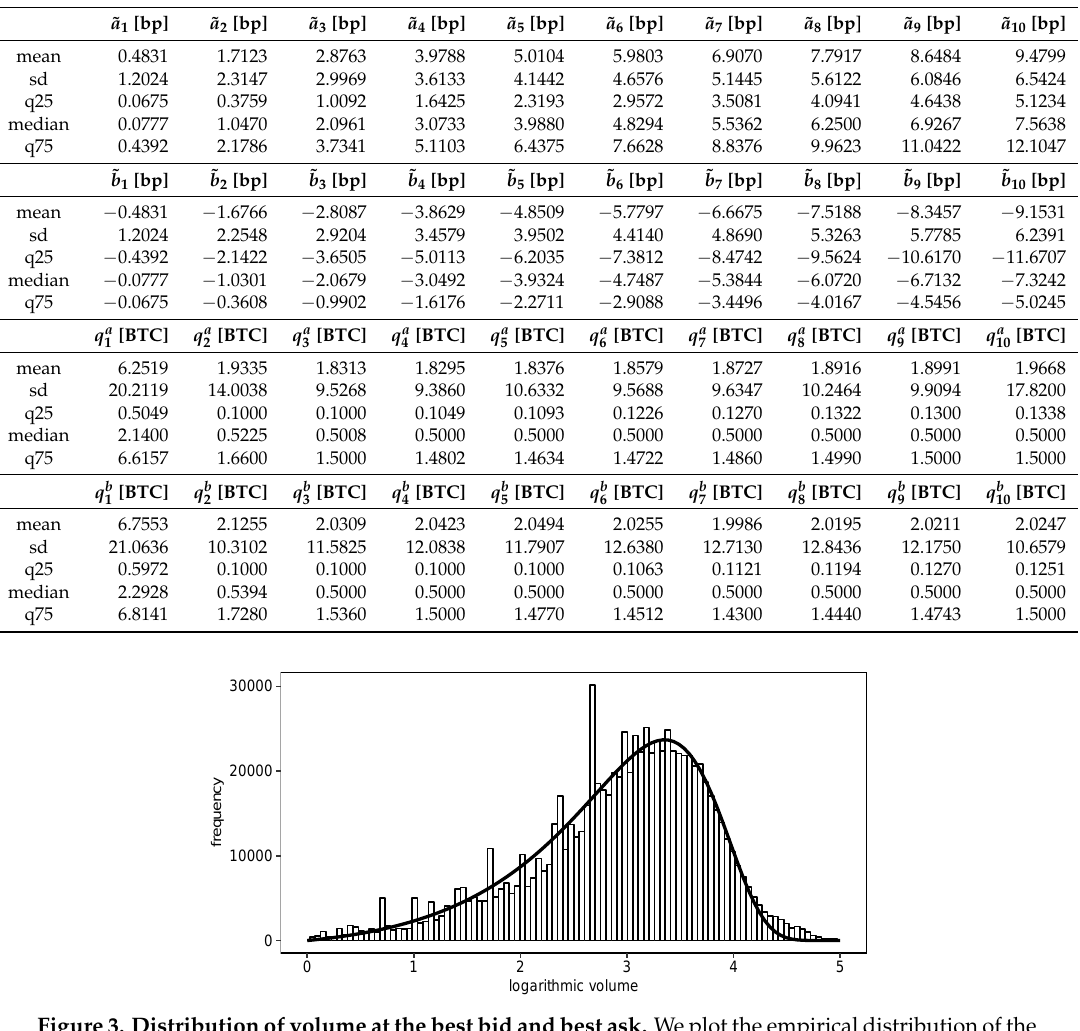
and q b ) at the first ten steps of the LOB. i i